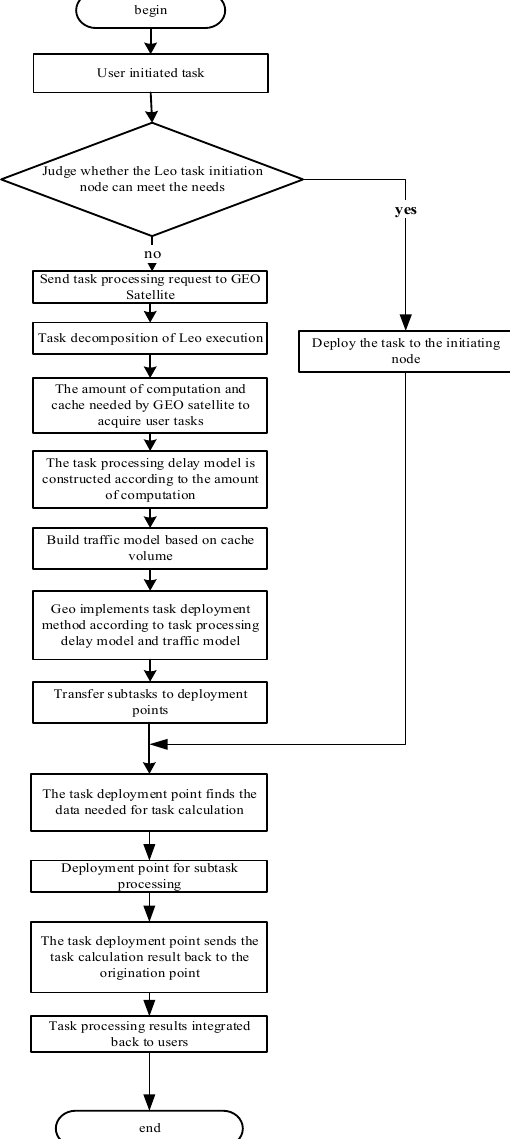
Figure 3. The flowchart of the task deployment method.